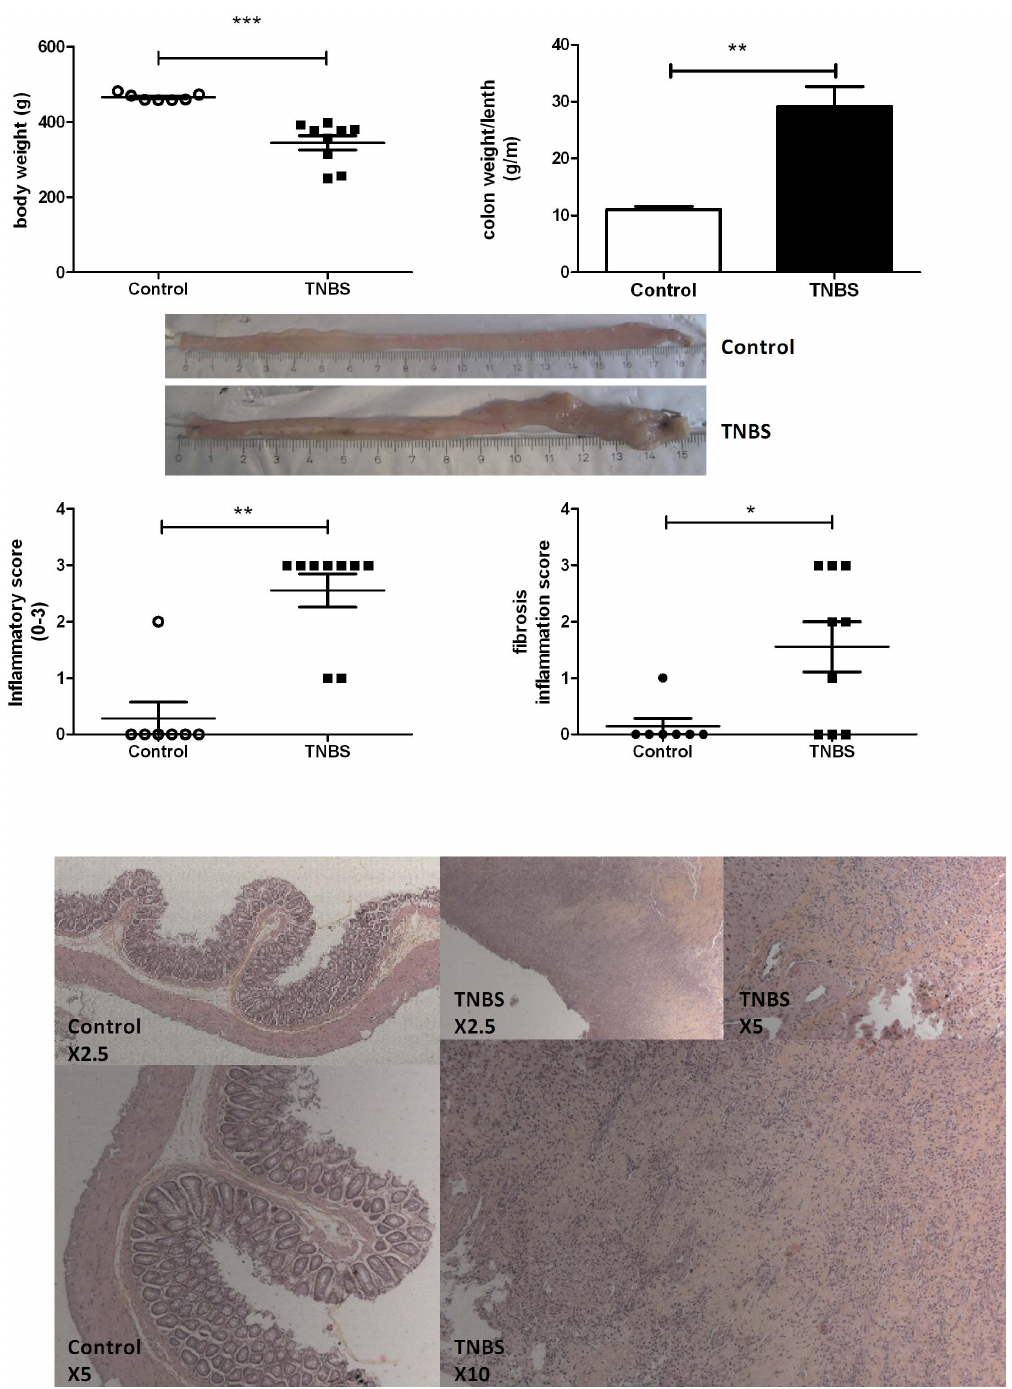
Figure 1. Validation of chronic TNBS-induced colitis. Chronic colitis was induced by weekly intrarectal injection of TNBS for 6 weeks. MRC was performed 1 week after the last injection. (A) Body weight on day of MRC. (B) Colon weight/length (g/m) in the control and TNBS group. (C) Colon macroscopy. (D) Histological score of inflammation from 0 (no inflammation) to 3 (severe inflammation). (E) Histological score of fibrosis from 0 (no fibrosis) to 3 (severe fibrosis). (F) Hematoxylin-eosin stained tissue of control and TNBS groups. In the TNBS sections, chronic inflammation and fibrosis occasioned architectural disorders, lymphocytic infiltrate and fibrin deposits. (Magnification, 6 2.5, 6 5, 6 10). Values are means 6 SEM. doi:10.1371/journal.pone.0100921.g001 TNBS and in none of the 7 controls (p = 0.09). There was no Correlation of MRC parameters and fibrosis parameters difference between the two groups regarding presence of tubular MRC measurement of wall thickness was significantly associ- aspect (p= 0.47) and wall signal intensity on T1 images (p = 0.46). ated with fibrosis scores, and a -SMA production (r =0.5813,